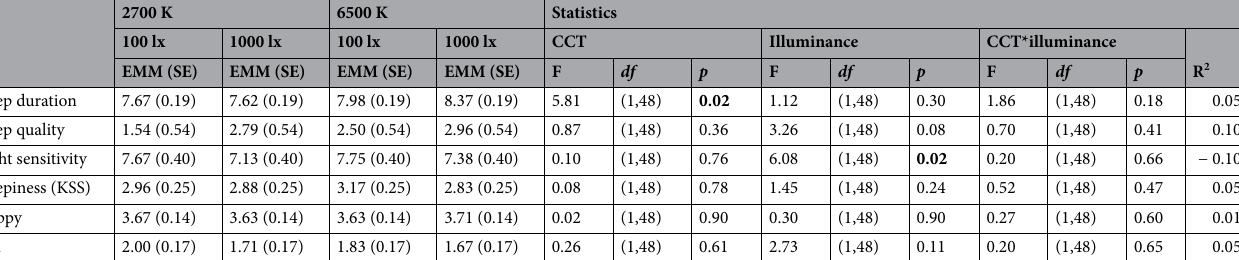
Table 2. Descriptive statistics results for confounding variables and baseline measures. EMM estimated marginal means, SE standard errors. A significant difference is indicated by bold labels. Effect sizes (pseudo R 2 -values (R 2pseudo )) indicates the proportion (percentage) of the reduction in the variance of residuals from the null model to the final (full) model at level two; it is worth mentioning that this measure can also have negative values 71